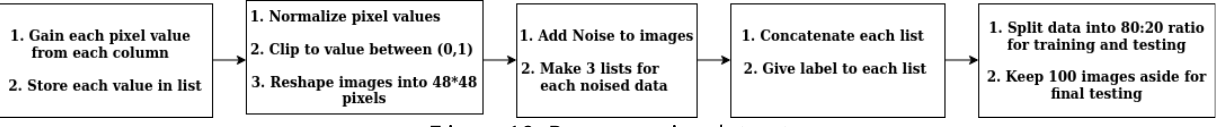
Figure 13. Preprocessing